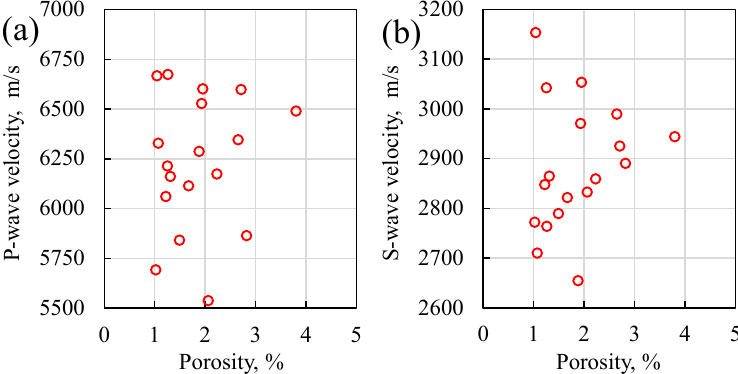
Figure 10. Cross plots of ( a ) P-wave and ( b ) S-wave speeds against He gas porosity. The data referring to both P- and S-waves are scattered.